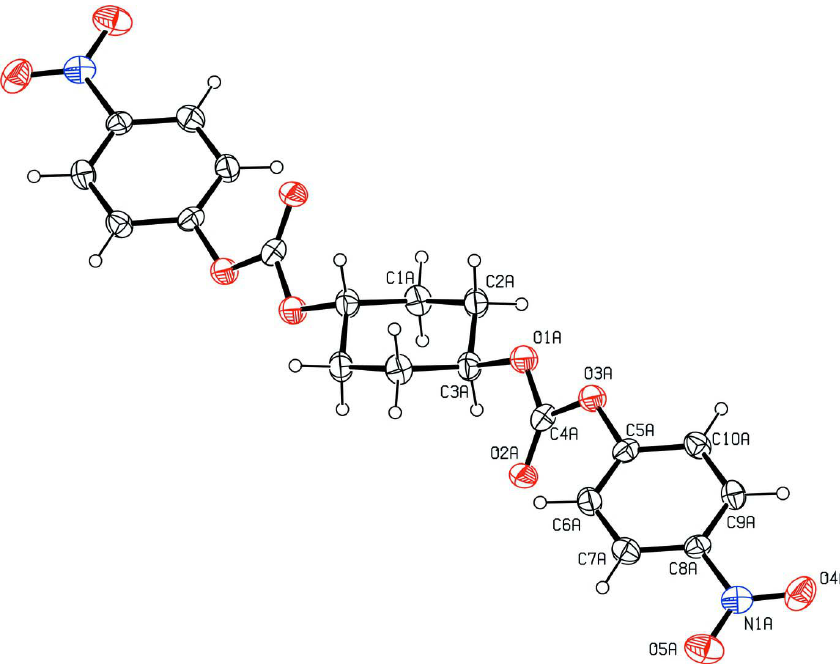
Figure 1 View of one of the independent molecules of the title compound with displacement ellipsoids drawn at the 30% probability level. Unlabeled atoms are related by the symmetry operator (- x , - y , 1 - z ).